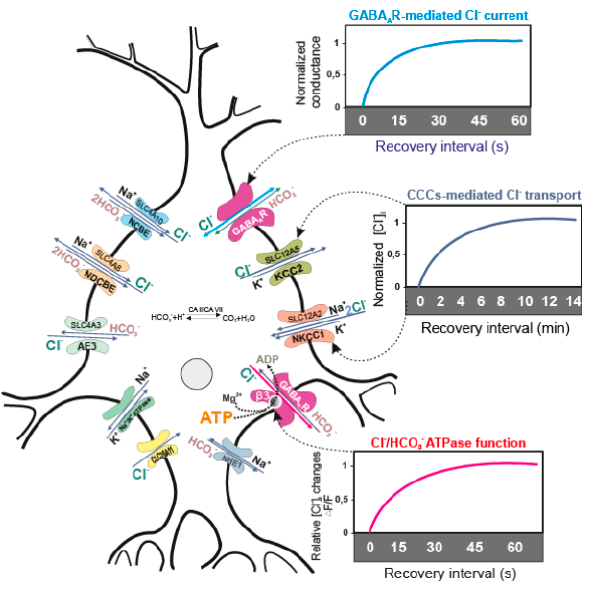
Figure 1. Performance of transporters and recovery of the receptor function. Neuronal [Cl − ] i is maintained mainly by neutral active CCCs (KCC2 and NKCC1), and less by Cl − channels ( SLC26 family) and exchangers ( SLC4 family—AE3, NCBE or NDCBE). CCCs move the Cl − ions by utilizing the energy electrochemical Na + and K + gradient, whose maintenance involves Na + , K + ATPase. CCCs need at least 5 min to recover [Cl − ] i [48,57,68–71], while the GABA A R-mediated conductance may recover during approximately 10–15 s after [Cl − ] i changes [51,61]. After purification and reconstitution into proteoliposomes, the β 3-containing GABA A R homopentamer participates in ATP- consuming Cl − transport for a short period (~30 s) and then reaches a plateau [35]. The bottom panel shows the changes of [Cl − ] i after application of Mg 2+ -ATP in the experimental medium containing proteoliposomes with embedded GABA A R/Cl − , HCO 3 − ATPase, as well as the fluorescent dye for